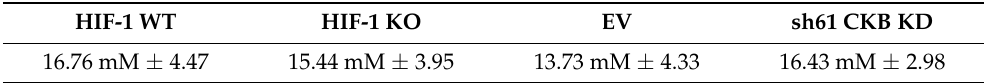
Table 1. Cyclocreatine (cCr) IC 50 values in PyMT ER-negative cell s . IC 50 values ± SEM were determined at 96 h, as described in the Materials and Methods section. IC 50 values for independent experiments were calculated using non-linear regression and variable slope fit in Prism 9.0. Results from independent experiments were averaged to report the mean ( n = 6, WT; n = 6, HIF-1 KO; n = 4, EV; n = 6,